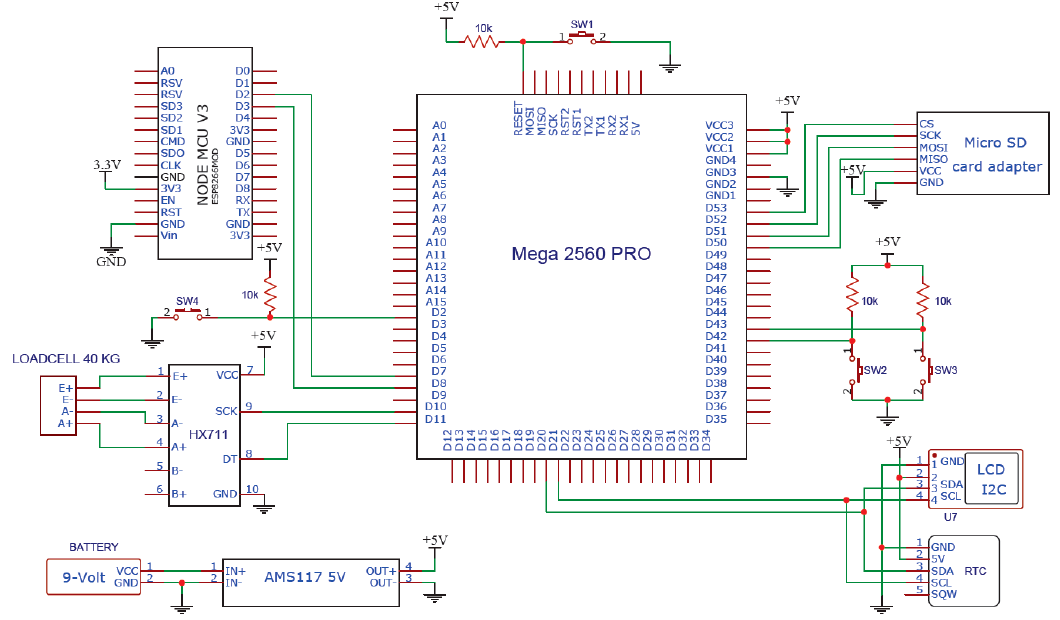
Figure 5. Circuit diagram for the proposed system.